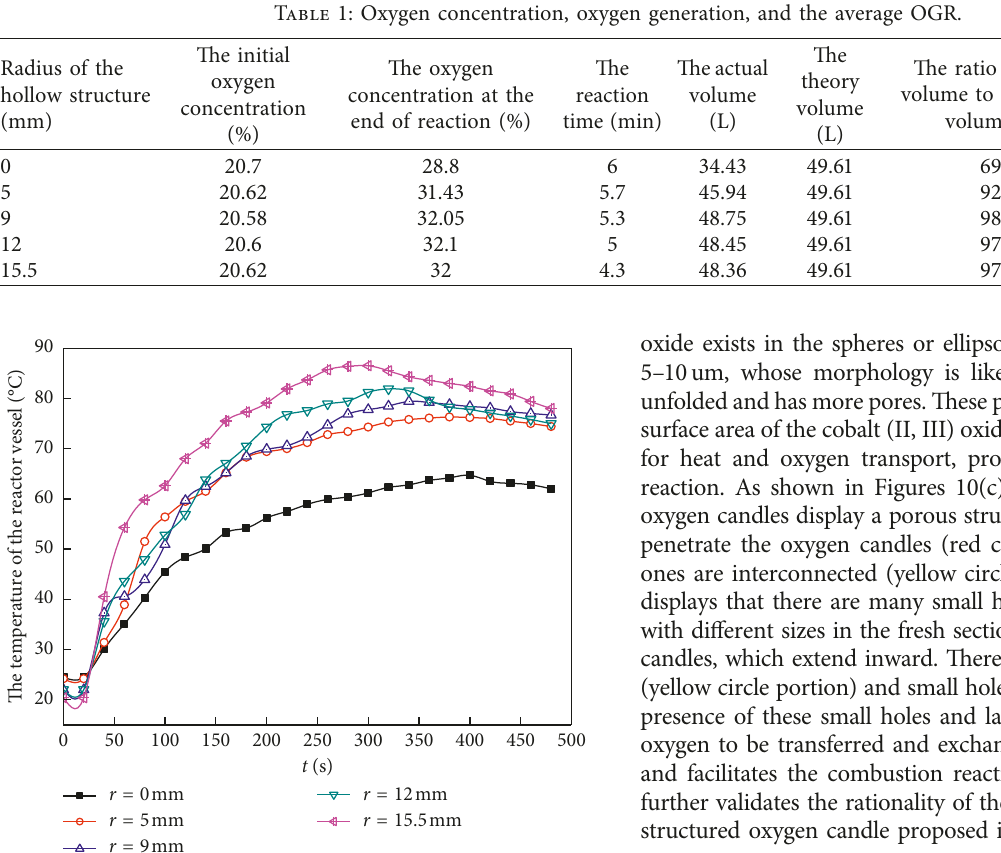
Figure 9: Relationship between the temperature and time.